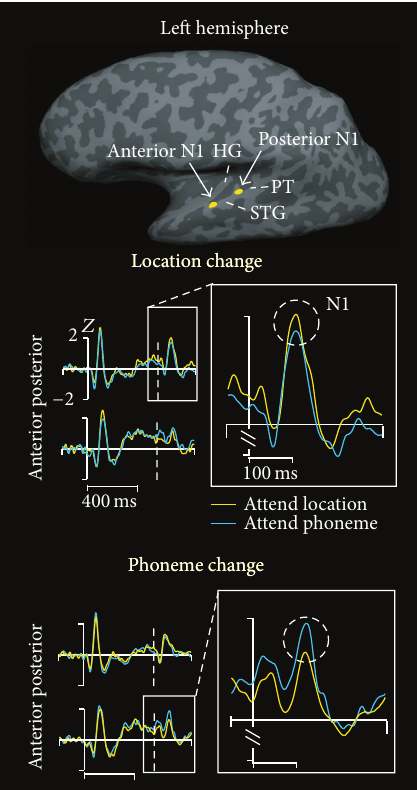
Figure1:Task-specificattentionalmodulationofanteriorandposteriorauditory-cortexselectivitytophoneticcategoryversusspatiallocation ofsoundsource.PairsofFinnishvowels/æ/and/ø/werepresentedfromstraightaheador45degreestotheright.Thestimuliwerepresentedin pairs, adaptor followed by probe, which were spatially discordant, phonetically discordant, or identical. In attend location condition, subjects responded to sound pairs that matched the spatial pattern of the preceding sound pair (i.e., same sound source locations in the same order), irrespective of the phonetic content. In the attend phoneme condition, the targets were, in turn, sound pairs phonetically similar to the preceding sound pair (same phonemes in same order), irrespective of the spatial content. At the top is shown inflated left hemisphere with the locations of the anterior and posterior N1 sources (i.e., responses elicited ∼ 100ms from sound onset). As can be seen in the middle panel, the posterior N1 response amplitude to the probe following a spatially different adaptor stimulus was enhanced when subjects selectively attended spatial cues. Conversely, as seen in the bottom panel, anterior N1 activity to probes following phonetically different adaptor stimuli was enhanced by phonetic attention. This task- and cortical-location-specific reduction in a paired-stimulus adaptation paradigm suggested that neural selectivity to phonemes was increased in anterior auditory-cortex areas during selective attention to phonetic features, and that neural selectivity to spatial locations was increased in posterior nonprimary auditory-cortex during spatial selective-attention. These effects furtheroccurredrelativelyrapidly,sincethetaskchangedonceevery60 s(adaptedwithpermissionfrom[39];HG:Heschl’sgyrus;PT:planum temporale; STG: superior temporal